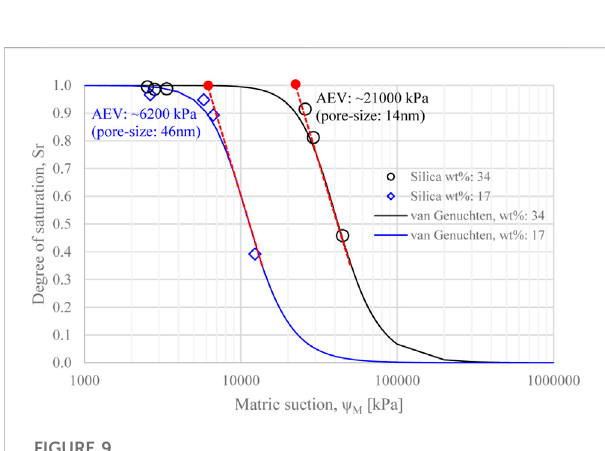
FIGURE 9 Water retention curves of CS gel samples at silica concentration wt% 34 and wt%